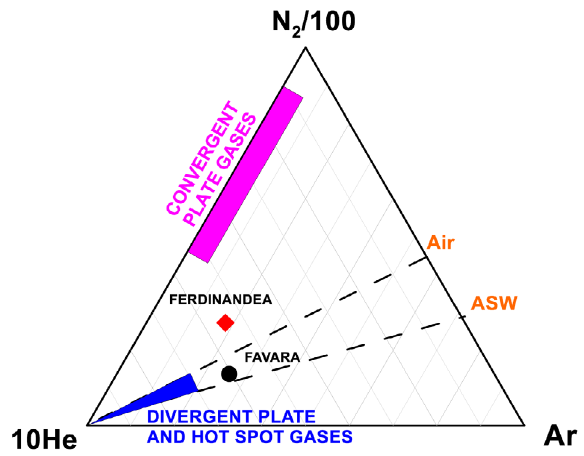
-Ar-He ternary plot: the sample from the Graham Bank Figure 10. N 2 (red diamond) falls toward the field representative of the gas emitted from volcanism associated to divergent plate (blue field). The N ratio slightly higher than air suggests the addition of nitrogen, likely organic and/or crustal in origin. For comparison, the sample Favara from Pantelleria Island (black dot) is also reported (data from Par- ello et al. [2000] and Tassi et al. [2012]); ASW=air saturated water.